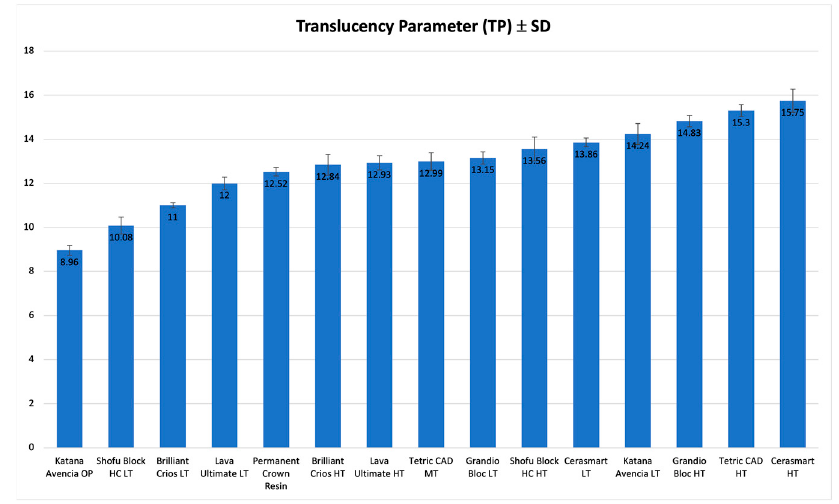
Figure 5. Graphic representation of TP for 1.0 mm of the investigated materials.